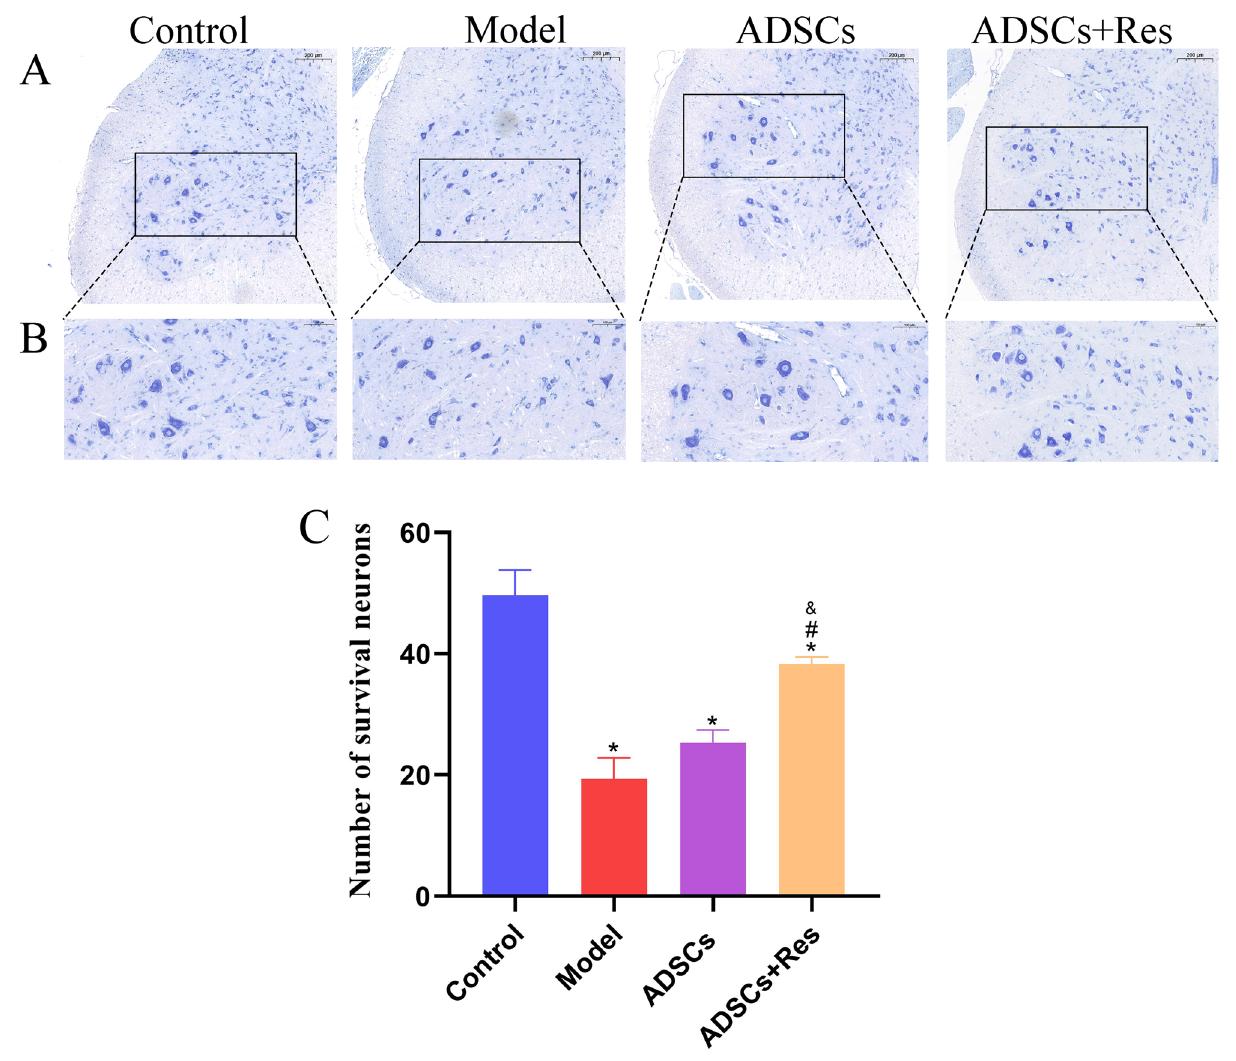
Figure 9. Histological assessment of the spinal cord. ( A , B ) L4 anterior horn Nissl staining; ( C ) The number of intact motor neurons in each group. * P < 0.05 compared with the control group, n = 5; # P < 0.05 compared